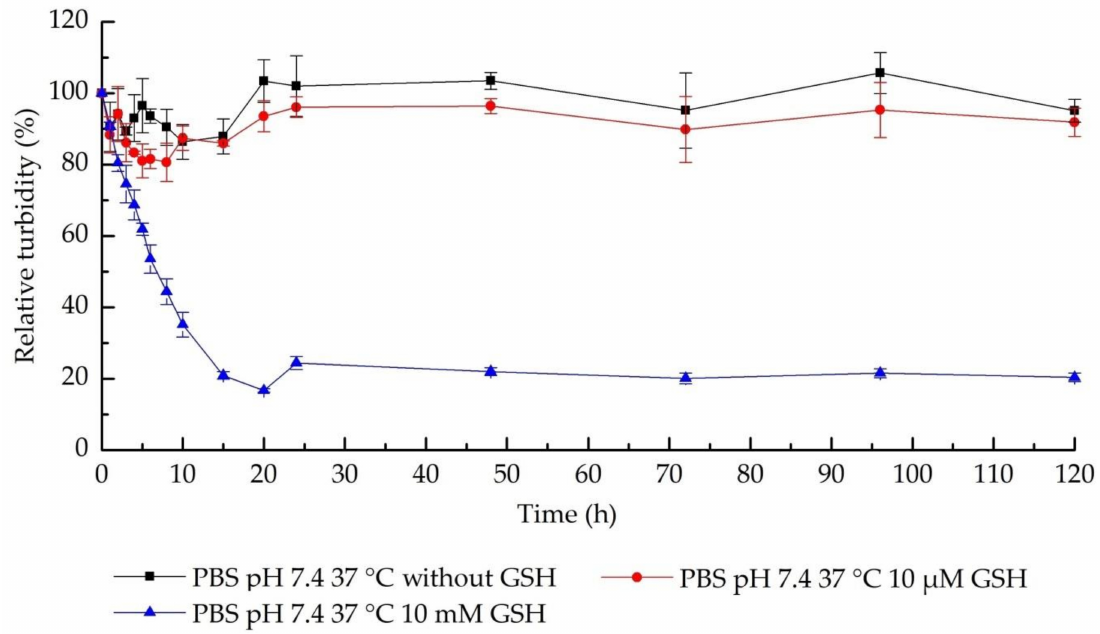
Figure 7. Characterization of redox response of nanohydrogel by relative turbidity